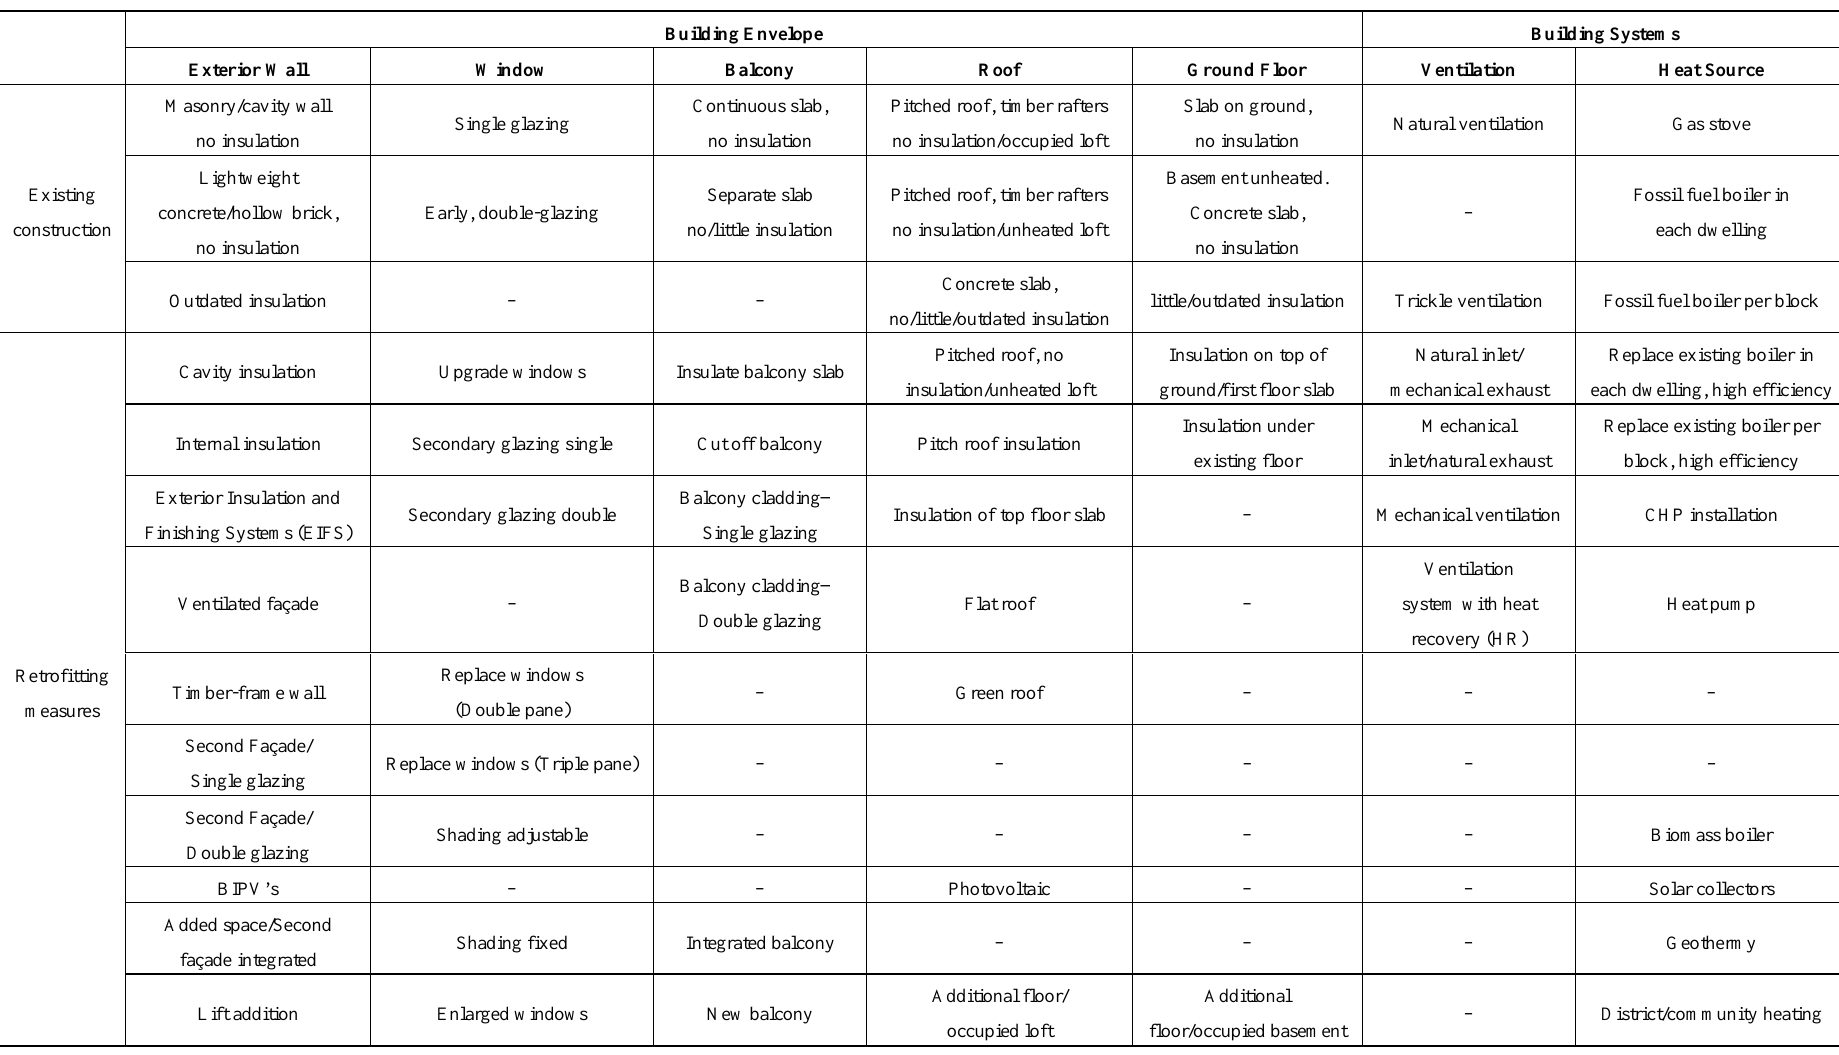
Table 1. The façade refurbishment toolbox matrix. The retrofitting measures refer to the building envelope, as well as building